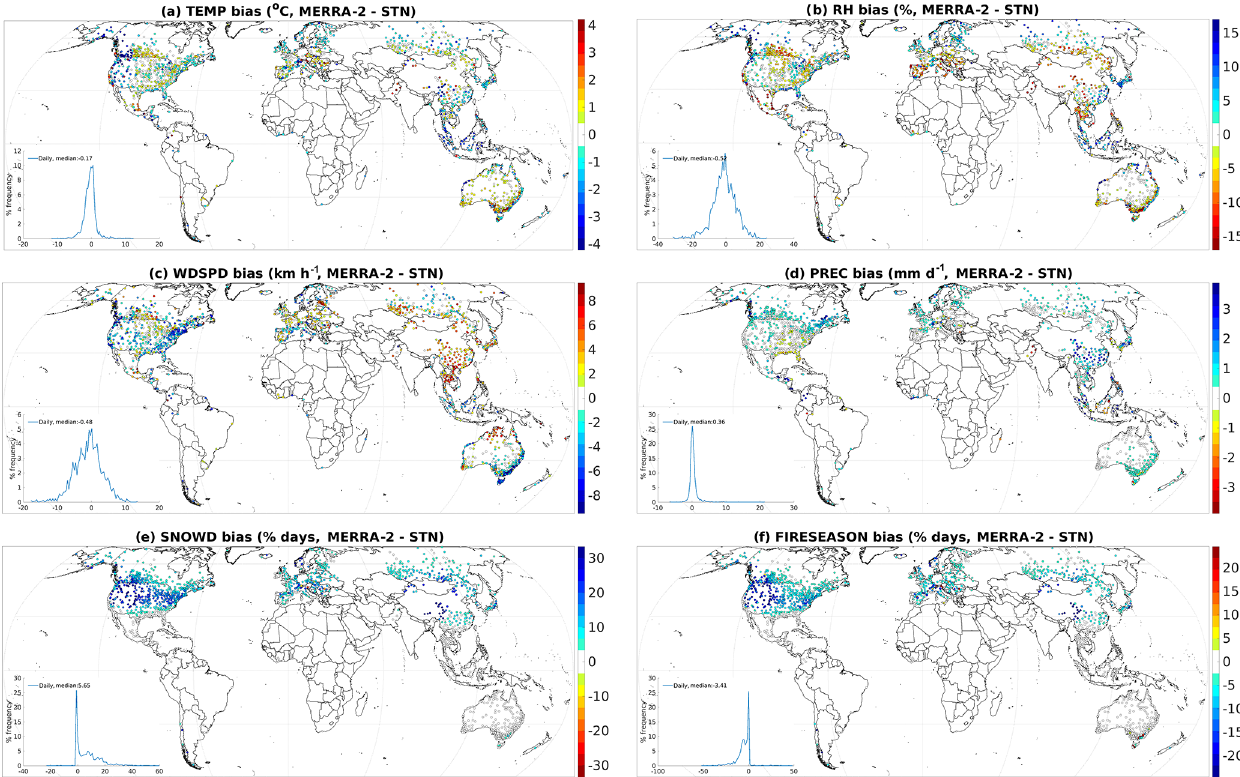
Figure 6. Same as Fig. 5 but for weather input variables. SNOWD (e) is expressed as the difference between MERRA-2 and the station data in the percentage of days during the year when snow depth is greater than 1cm, the threshold below which FWI calculations are active. FIRESEASON (f) is expressed as the difference between MERRA-2 and the station data in the percentage of days during the year when FWI calculations are